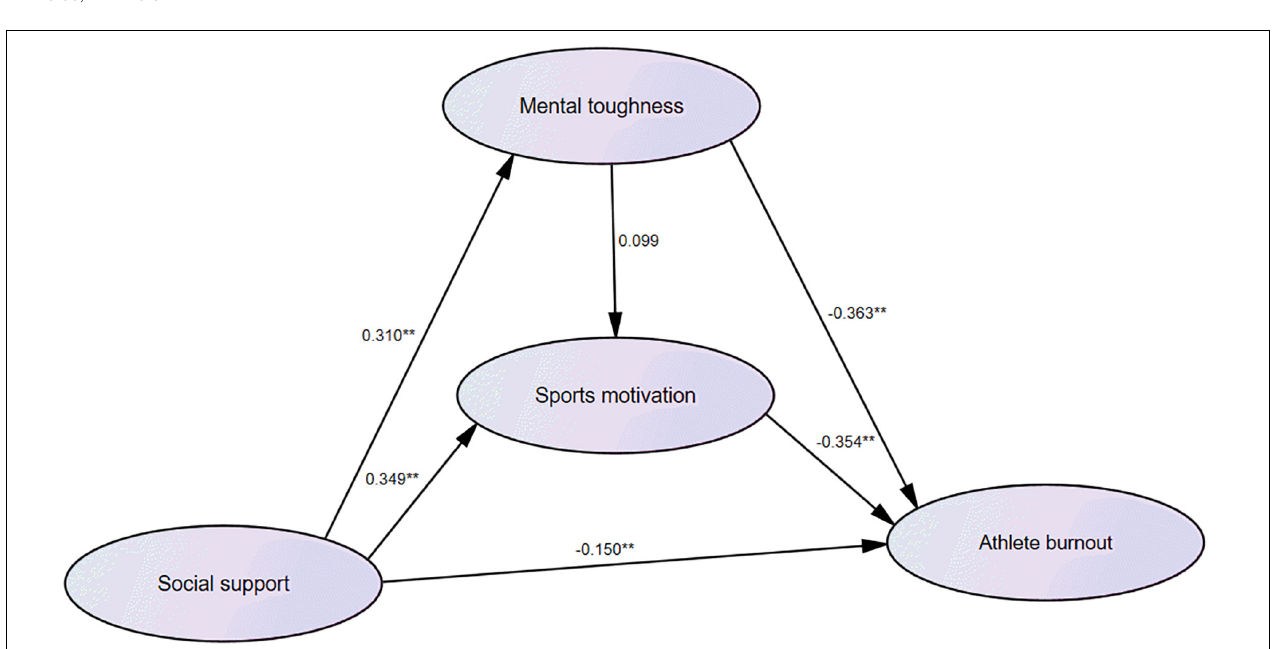
between social support and athlete burnout. Thus, hypothesis II is